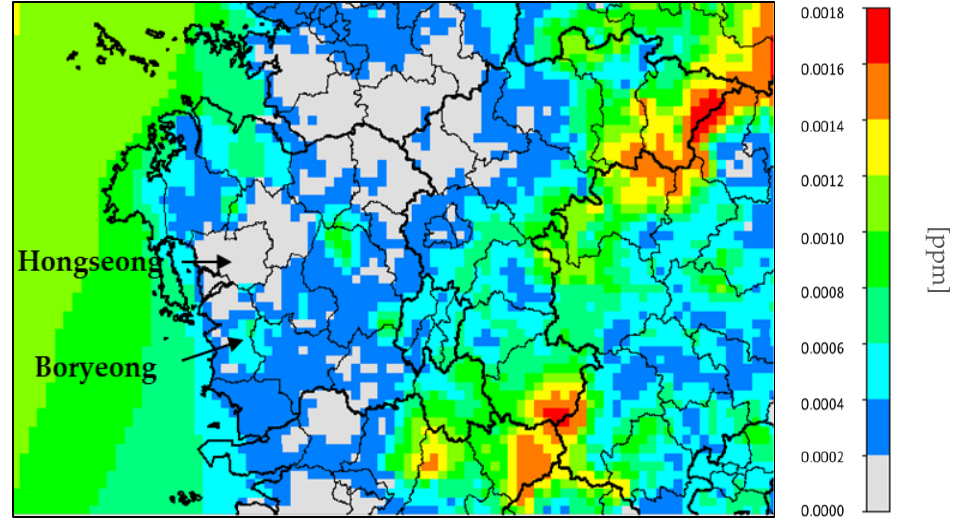
Figure 12. Monthly mean of HNO 3 concentration under Base scenario .